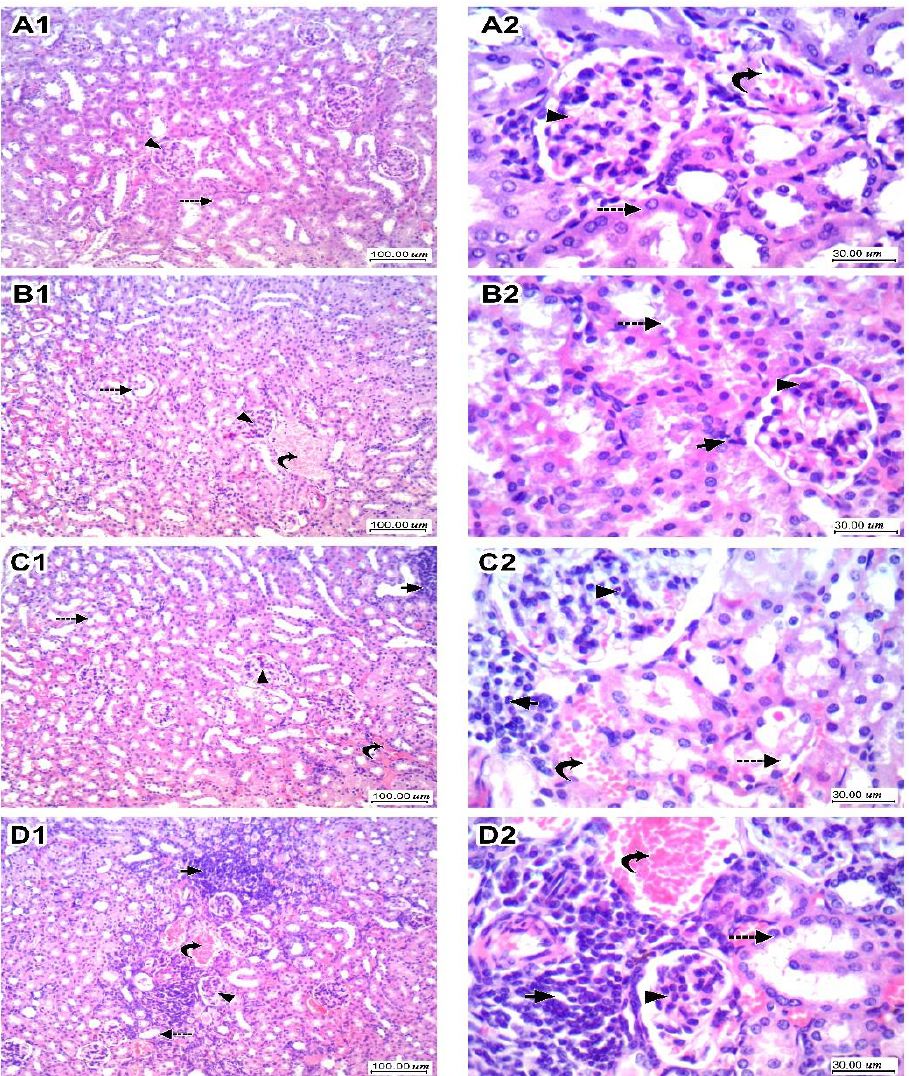
Figure 4. Histopathologic scores for hematoxylin and eosin-stained kidney specimens in mice treated with LEFN. Panel ( A1 , A2 ) show sections of kidney tissue in the vehicle group, showing regular tubules (dashed arrow) lined by epithelial cells with intact eosinophilic cytoplasm and regular nuclei, and glomeruli (arrowhead) showing capillary tuft with a thin wall and thin patent Bowman’s space and mesangial cells. Interstitium showed thin blood vessels (curved arrow) and loose intervening stroma. Panel ( B1 , B2 ) are kidneys from the LEFN 2.5 mg/kg group showing mild focal tubular (dashed arrow) hydropic degeneration of tubular epithelial cells, glomeruli (arrowhead) showing average normal cellularity, and stroma showing focal minimal lymphocytic inflammatory infiltrate (arrow). Panel ( C1 , C2 ) are for kidneys in the LEFN 5 mg/kg group showing moderate tubular (dashed arrow) hydropic and vacuolar degeneration of tubular epithelial cells, glomeruli (arrowhead) showing a slight increase in cellularity, and stroma showing focal mild congestion (curved arrow) and focal mild lymphocytic inflammatory infiltrate (arrow). Panel ( D1 , D2 ), the LEFN 10 mg/kg group showed moderate hydropic degeneration of tubular epithelial cells (dashed arrow), and glomeruli showed a moderate increase in cellularity with irregularity and focal shrinkage (arrowhead). There is interstitial congestion and focal hemorrhage (curved arrow) with moderate lymphocytic inflammatory infiltrate (arrow), ×100 and ×400, respectively.